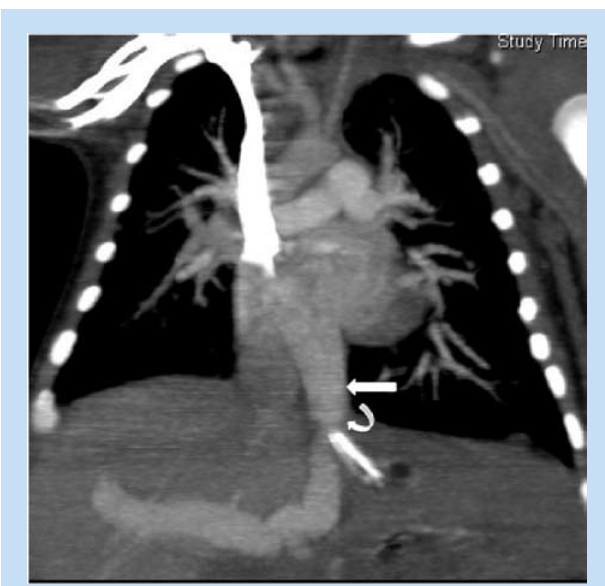
Fig. 2b. MIP reconstruction showing the common pulmonary venous channel (straight arrow) descending through the diaphragm to drain into the portal venous system. Note the narrowing of the common venous channel at the oesophageal hiatus (curved arrow), the position confirmed by the nasogastric tube.